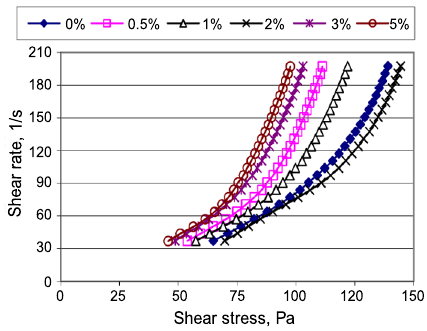
Fig. 4. Cement paste with CEM I R cement shear stress vs shear rate after mixing